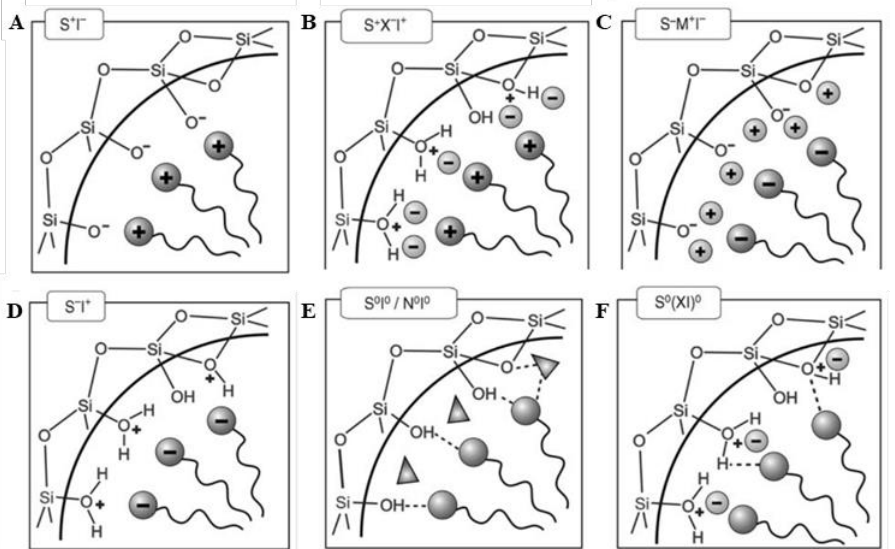
Figure 11. Schematic representation of the possible interactions between silica precursors and surfactant molecules [22]. Reprinted with permission from [22]. Copyright 2006, John Wiley and Sons.